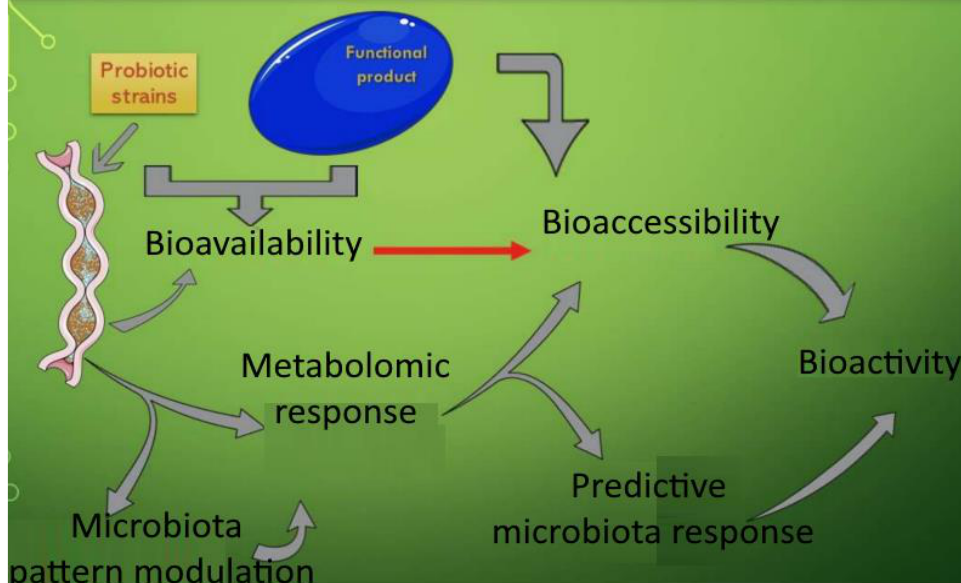
Figure 6. The influence of microbiota bioactivity and bioavailability of functional compounds. Figure 6 is adapted from Vamanu and Gatea [125] (Copyright © 2020 by authors), which is an open